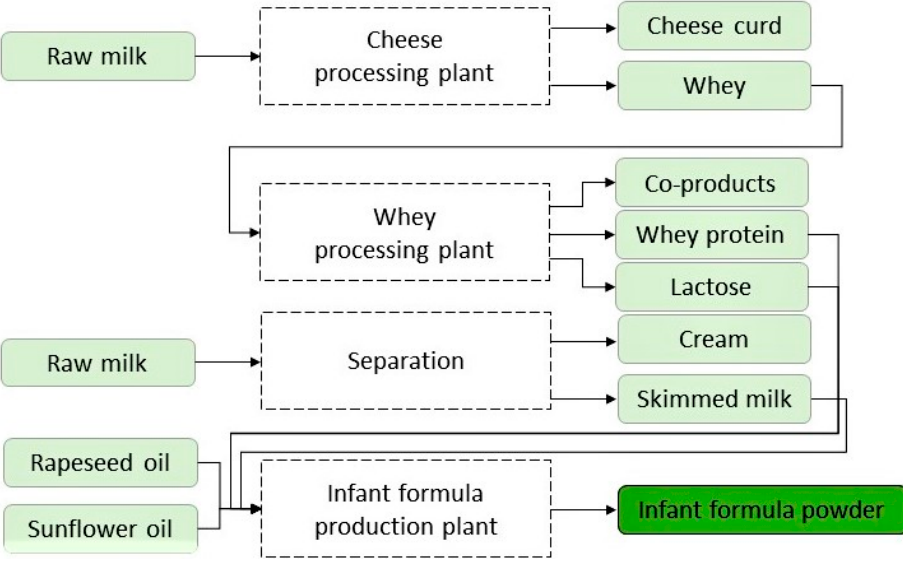
Figure 1. The processes involved in the production of infant formula included in the life-cycle assessment, adapted from Karlsson et al., 2019 [27]. The amount of raw ingredients (raw milk, rapeseed oil, and sunflower oil) and energy used for processing of 1 kg infant formula powder is provided in Table S1.